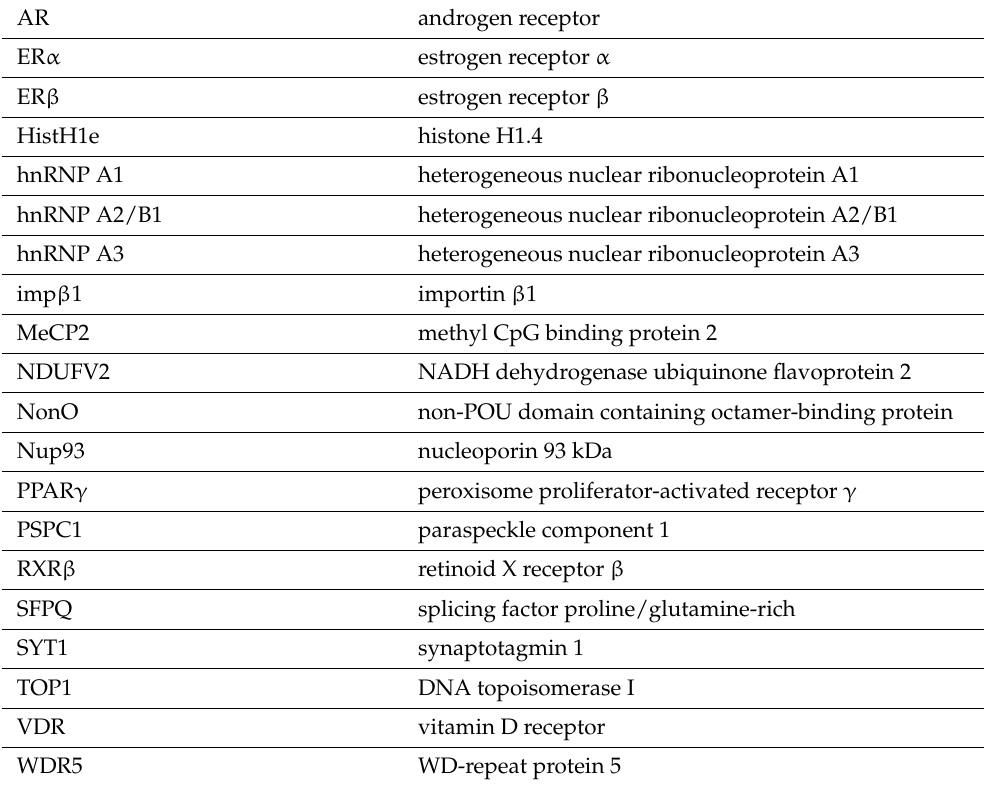
Table 1. L1 binding partners assayed in this